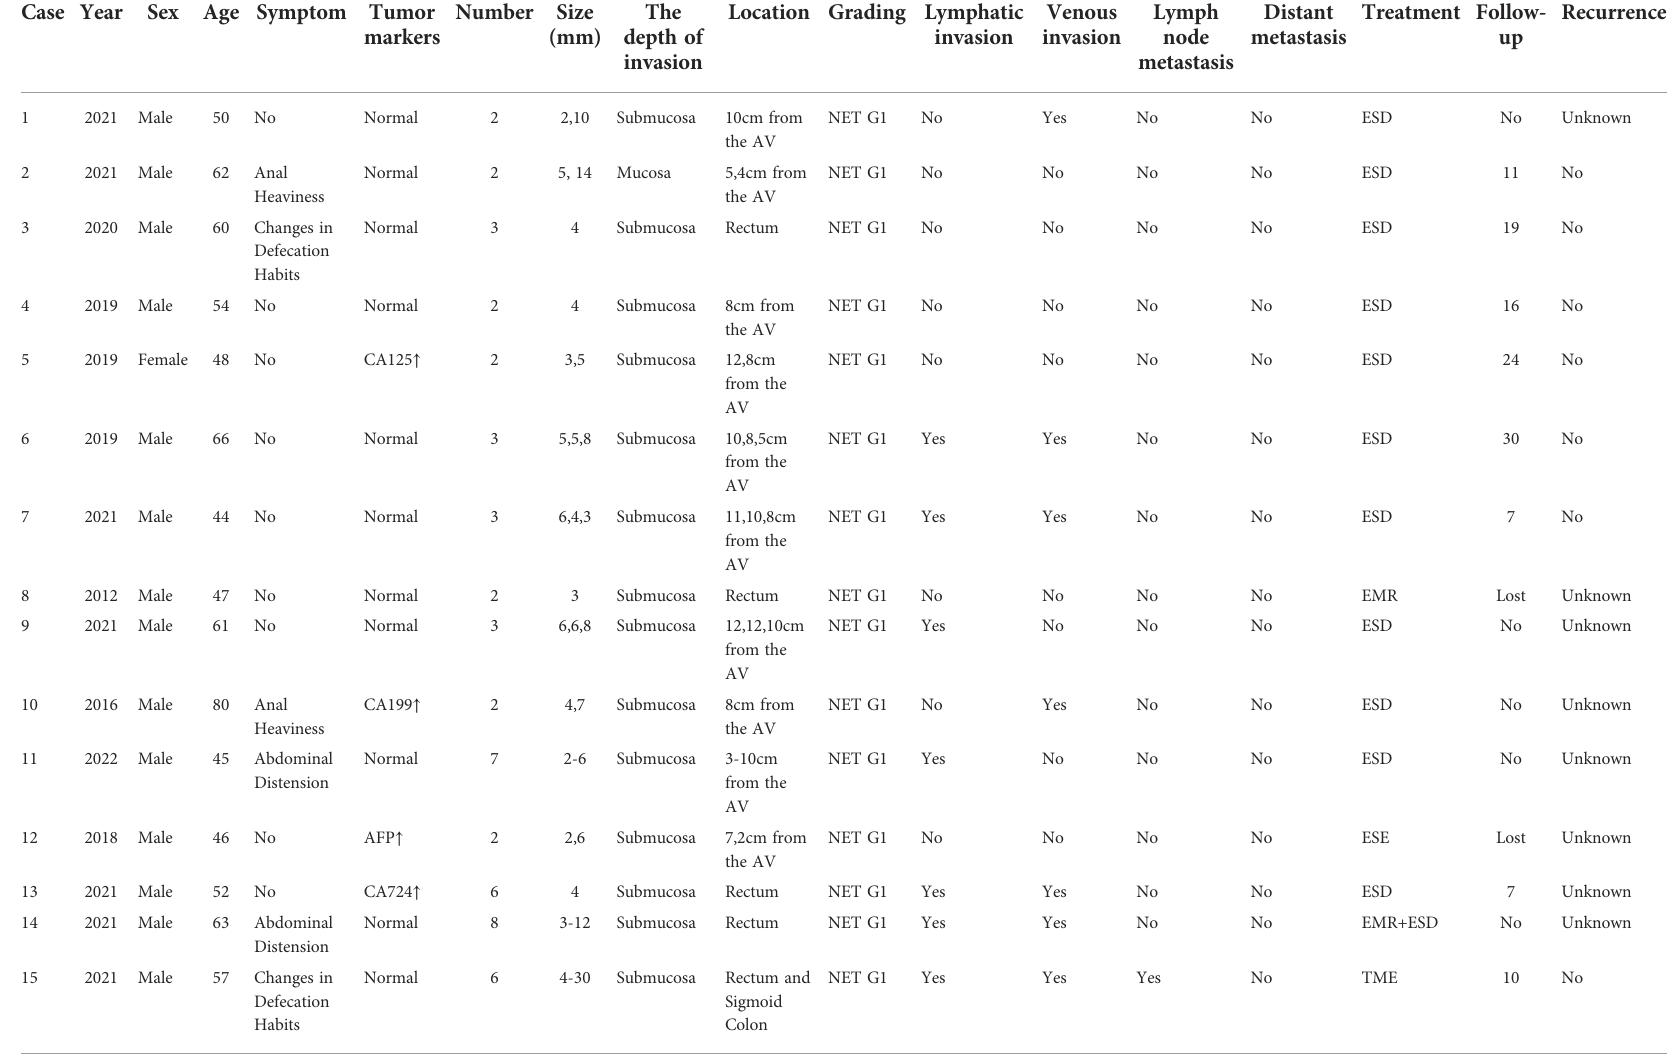
TABLE 1 Summary of our fi fteen